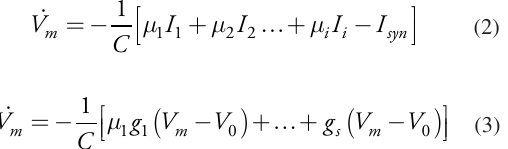
Table 1. Parameter values for I Na , I K , I leak as in 20 , I CaL as in 21,22 for activation (m) and inactivation (h) (se e Equation 1 ). Exponents (p, q), conductanc e g – (in mS) and parameters are shown. The types of equations (Eq a , Eq b ) are 1 for exponential, 2 for logistic, and 3 for linexp (see text for the equations). The reversal potential E rev is given in mV. I p q